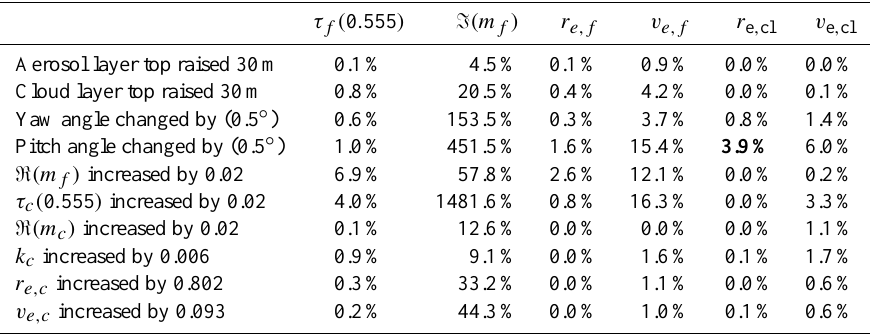
Table 4. This table contains the parameter sensitivity to changes in the forward radiative transfer model. This sensitivity is expressed as a percentage of the retrieved parameter value ((100 × e / x )). All of the parameter errors from model uncertainties are within the accuracy requirements of Mishchenko et al. (2004), and with one exception (the pitch angle uncertainty impact on the cloud effective radius, noted in bold), they are all less than the individual retrieval uncertainties. τ f ( 0 . 555